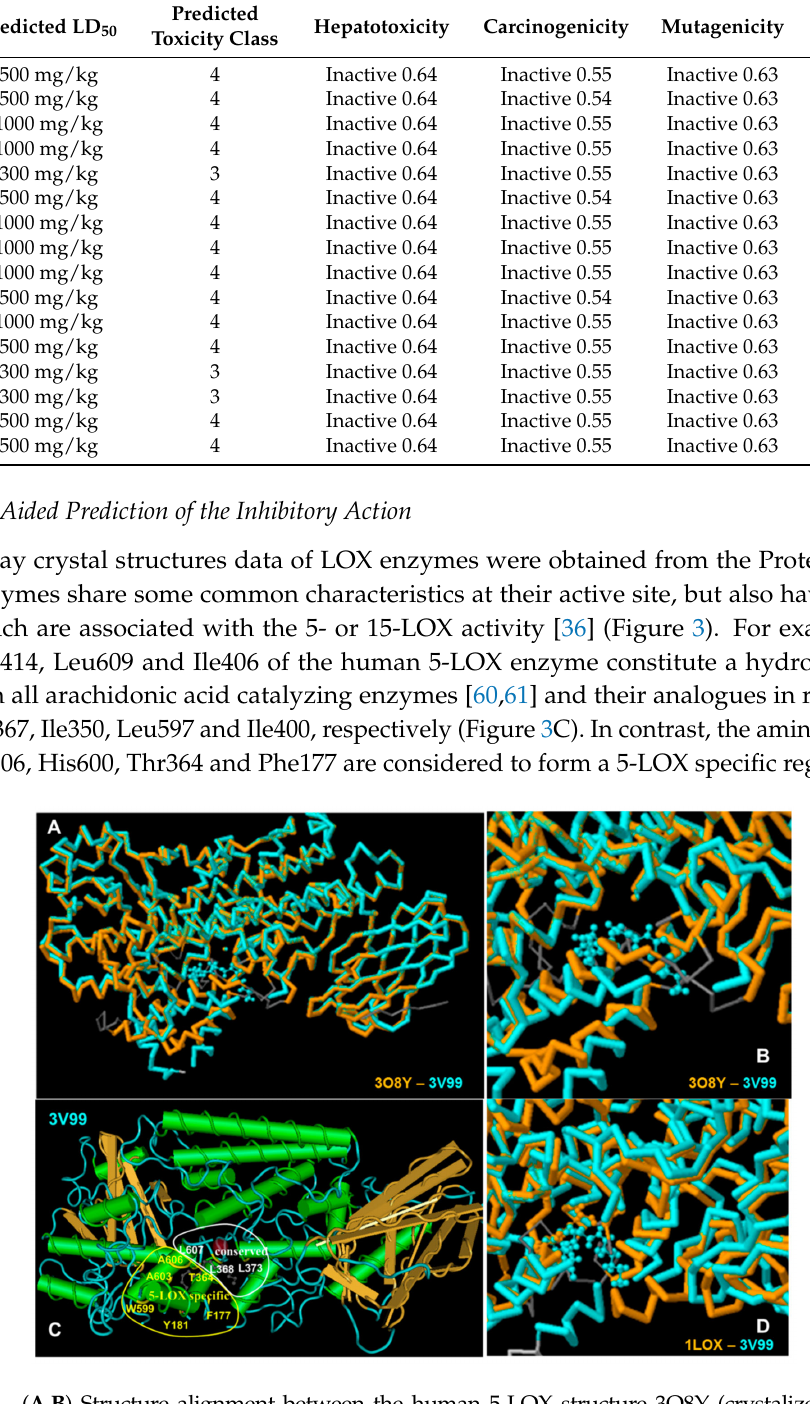
Figure 3. ( A , B ) Structure alignment between the human 5-LOX structure 3O8Y (crystalized without substrate or inhibitor) and human 5-LOX structure 3V99 (crystalized with arachidonic acid); ( C ) Amimno acids of human 5-LOX (structure 3V99), conserved in all LOX enzymes (white region), and 5-LOX specific amino acids (yellow area); ( D ) Structure alignment between the rat 15-LOX, structure 1LOX (crystalized with inhibitor) and human 5-LOX structure 3V99 (crystallized with